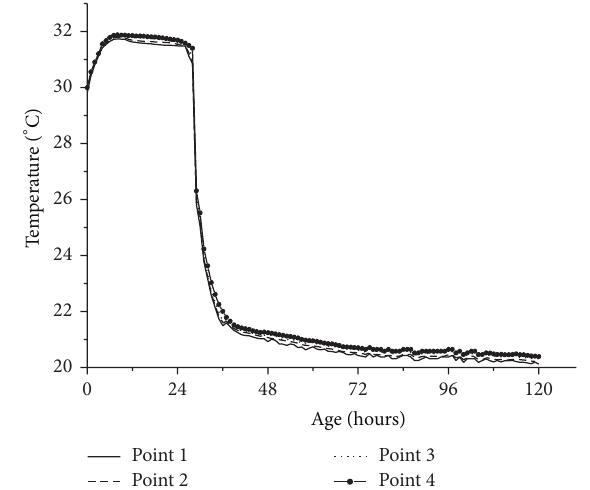
Figure 4: Measured temperature development of mortar